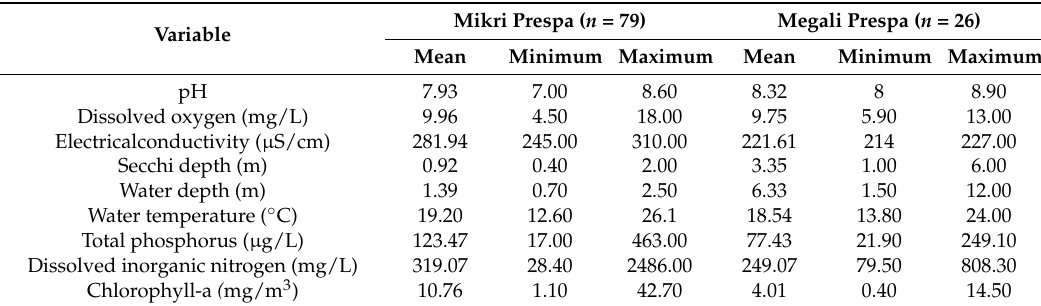
Table 1. Statistical description of the seasonally measured environmental parameters for Lakes Megali Prespa and Mikri